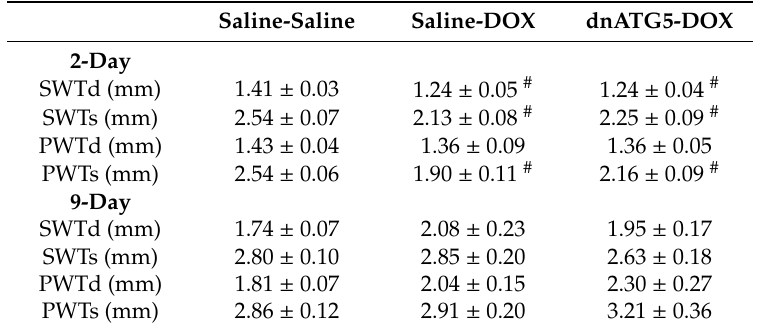
Septal wall thickness during diastole (SWTd) and systole (SWTs). Posterior wall thickness during diastole (PWTd) and systole (PWTs). Values are presented as means SEM. n = 6–9/group. # significantly different versus Saline-Saline ( p < 0.05).